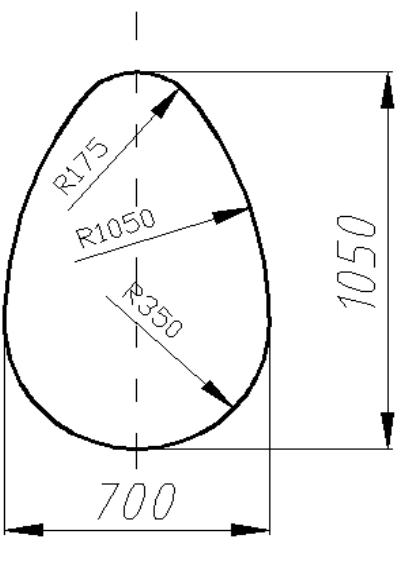
Figure 1: Internal dimensions (in mm) of the conduit’s cross